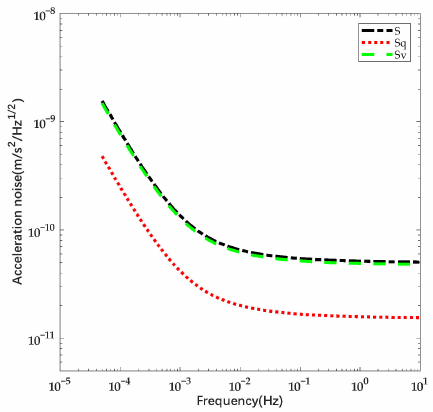
Figure 3. Estimation of acceleration noise caused by listed factors, S presents the total noise, S q presents the noise due to emitted charge and S v presents the noise due to deviation